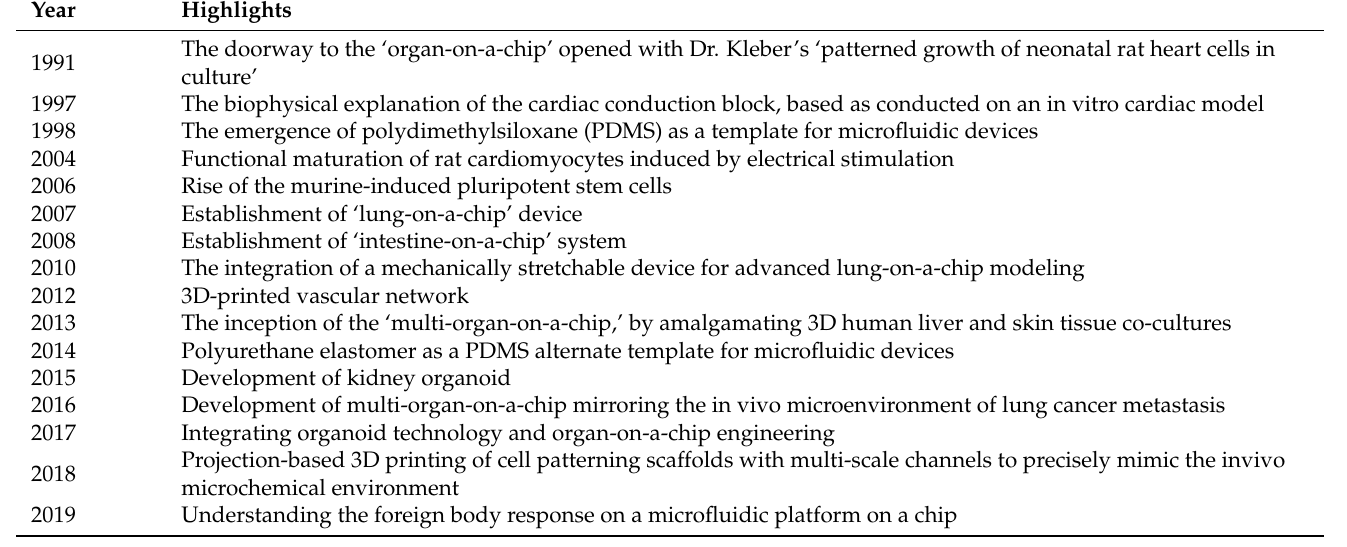
Table 1. The main discoveries/highlights in the organ-on-a-chip realm.